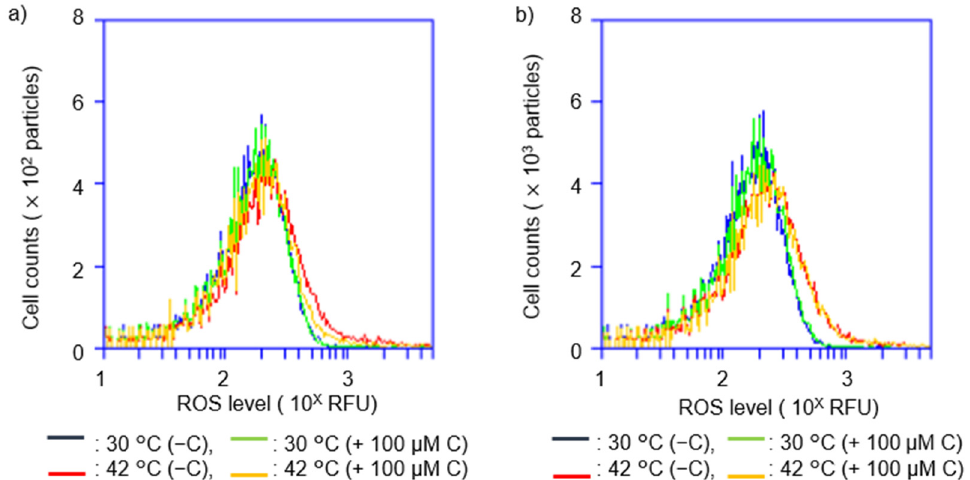
Figure 4. Comparison of reactive oxygen species (ROS) accumulation in restrictive and permissive conditions for recAts polA and recAts polA Δ hslO cells. ( a ) Comparison of ROS accumulation in restrictive and permissive conditions in recAts polA cells in a shift-up experiment. In the early logarithmic growth phase (O.D. 600 = 0.1), the TK3077 ( recAts polA ) culture was divided into three portions, and each was incubated at 30 °C and 42 °C either with or without vitamin C. The ROS levels in the TK3077 ( recAts polA ) cells were determined using CellROX Deep Red staining. ROS levels are compared at the time of division and 16 h after cultivation at 30 °C and 42 °C. Histograms show 30 °C without vitamin C (blue), 30 °C with 100 μ M vitamin C (green), 42 °C without vitamin C (red), and 42 °C with 100 μ M vitamin C (orange). A total of 20,000 particles are shown. ( b ) Comparison of ROS accumulation in restrictive and permissive conditions in recAts polA Δ hslO cells in a shift-up experiment. ROS levels of TK3276 ( recAts polA Δ hslO ) culture were determined. Histograms are labeled as in ( a ).